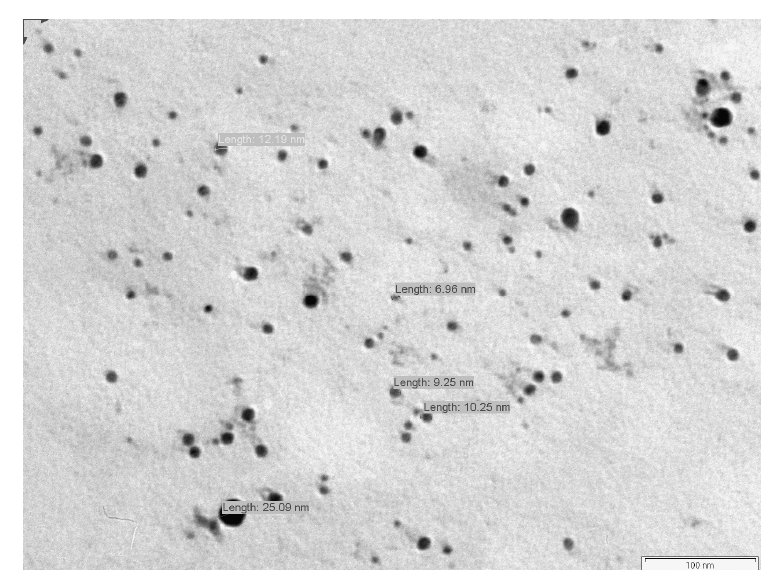
Figure 4. TEM micrograph at 100,000 times magnification recorded from a drop-coated film of 1 mM aqueous solution of AgNO with Bacillus subtilis culture supernatant 3 irradiated with microwave. The scale bar corresponds to 100